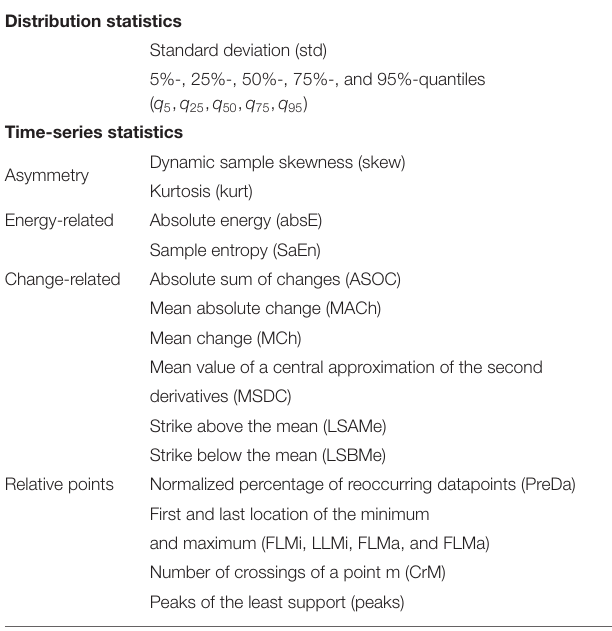
TABLE 1 | List of simple statistics and more complex time-series statistic features extracted by our